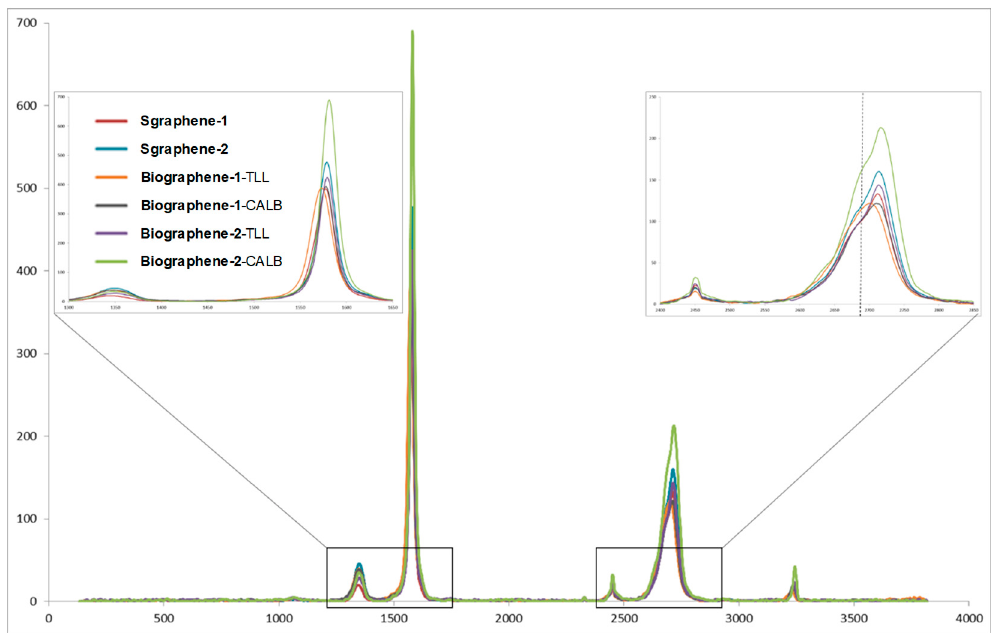
Figure 9. Raman spectra of the different biographene materials.